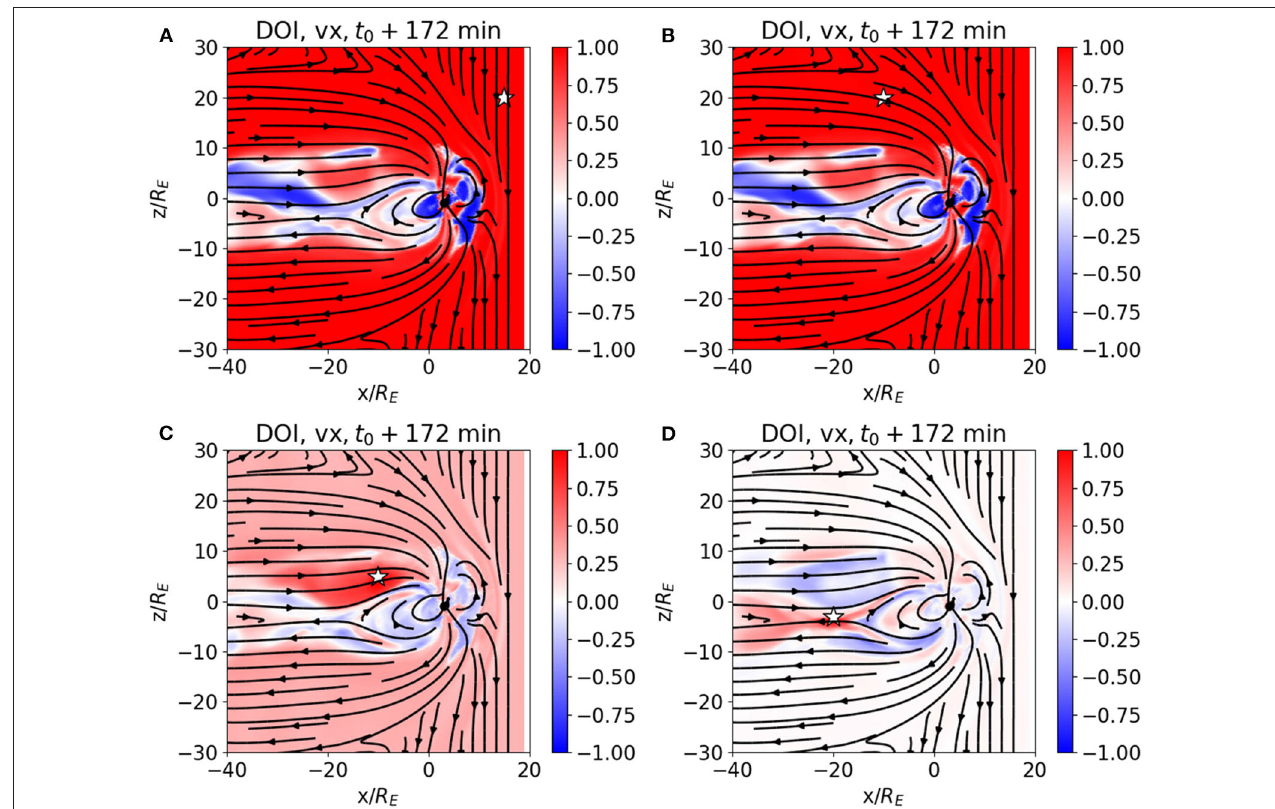
FIGURE 3 | DOI maps for v x , computed from the correlation of an ensemble of OpenGGCM magnetospheric simulation, with observation points in the solar wind (A) , magnetosheath (B) , northern lobe (C) , plasma sheet (D)